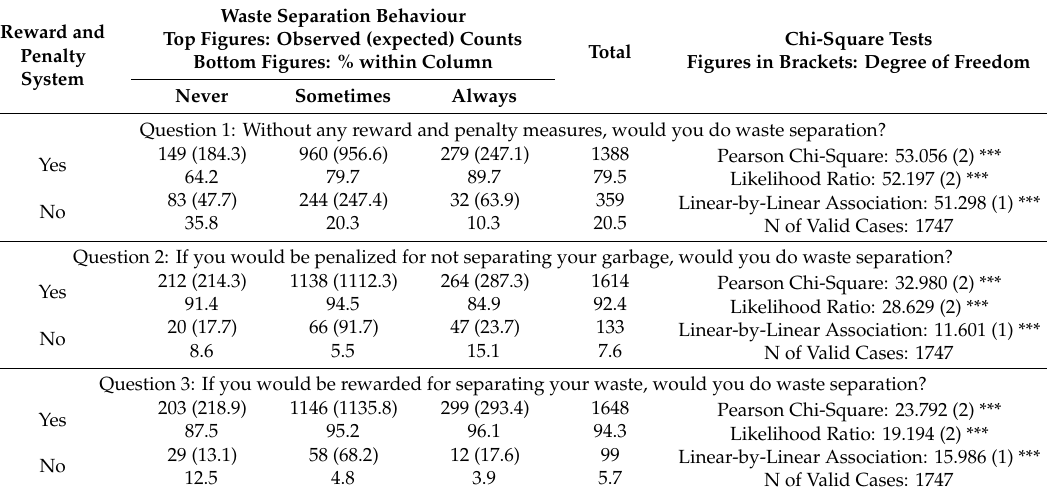
Table 9. Reward and penalty system and waste separation